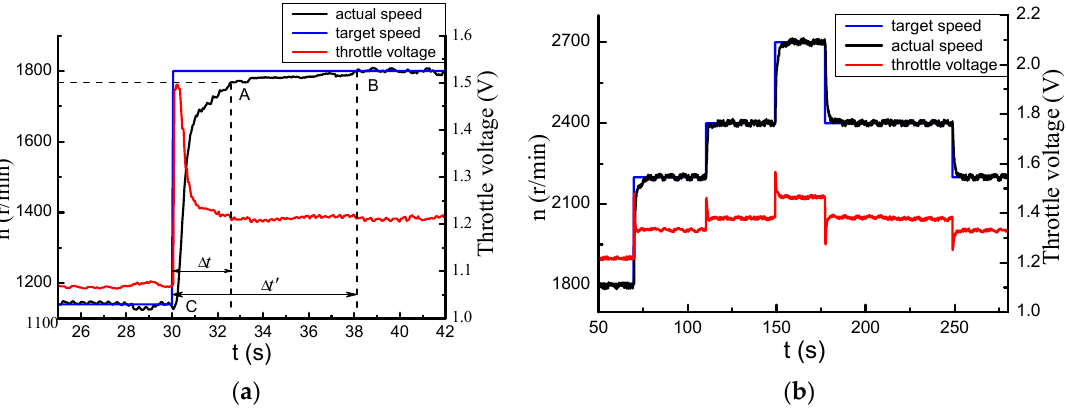
Figure 13. Engine speed step response curve under no-load: ( a ) Fast response speed; ( b ) Follow the target speed changes well.